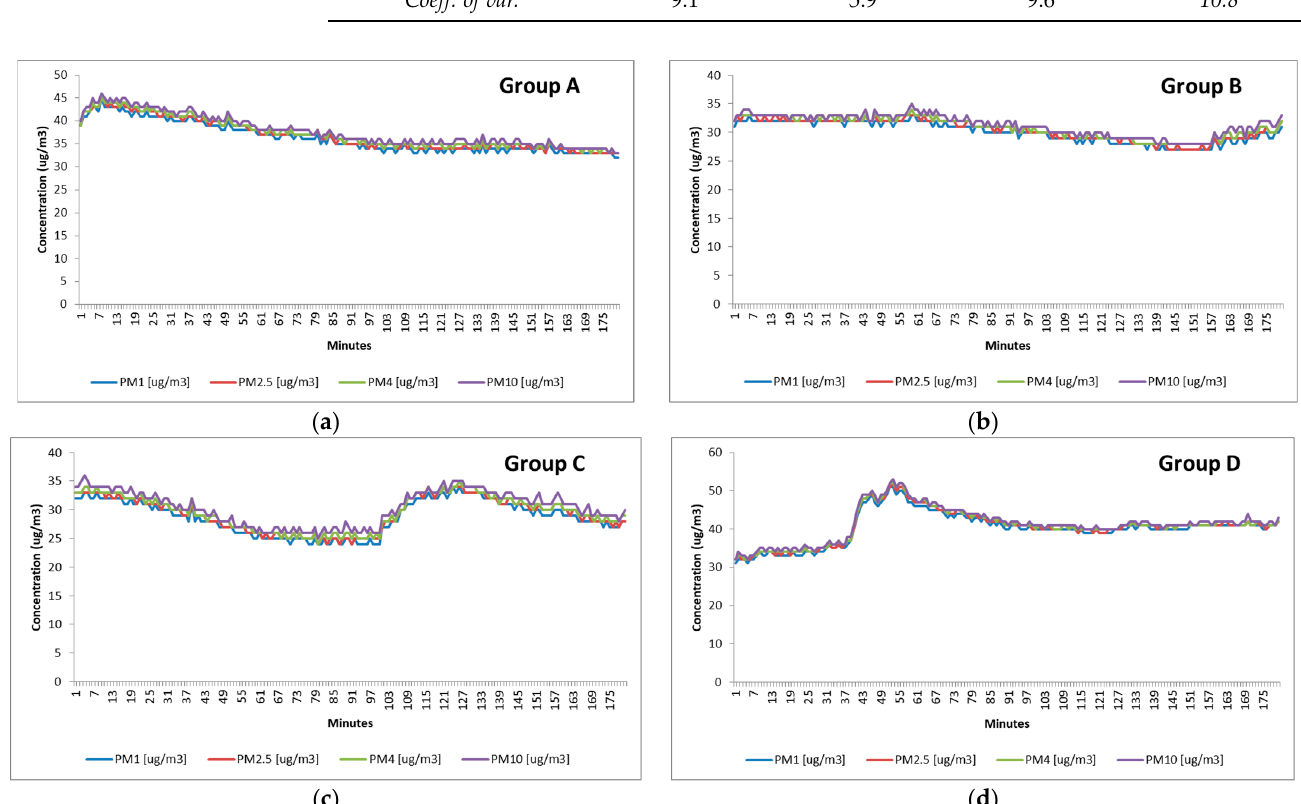
Figure 1. Time series of the concentrations of the size segregated mass fractions of particulate matter ( μ g m − 3 ) recorded in a classroom using a TSI DustTrak TM DRX 8533 EP during three hours of lectures and the equations of corresponding linear trendlines: ( a ) Group A: y = − 0.0618 x + 43.436 (R ² = 0.86 ) ; ( b ) Group B: y = − 0.0288 x + 33.429 (R ² = 0.69 ) ; ( c ) Group C: y = − 0.0002 x + 30.3994 (R ² = 0.00 ) ; ( d ) Group D: y = 0.0214 x + 39.407 (R ² = 0.06 ).